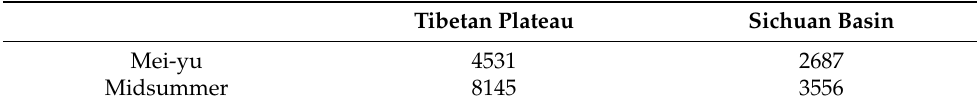
Table 1. The number of precipitation features (Unit: hour) from the Hydro-Estimator Satellite Rainfall Estimates dataset in the two subregions within 28 ◦ –34 ◦ N shown in Figure 1 in each of the two chosen seasons. Tibetan Plateau Sichuan Basin Mei-yu 4531 2687 Midsummer 8145